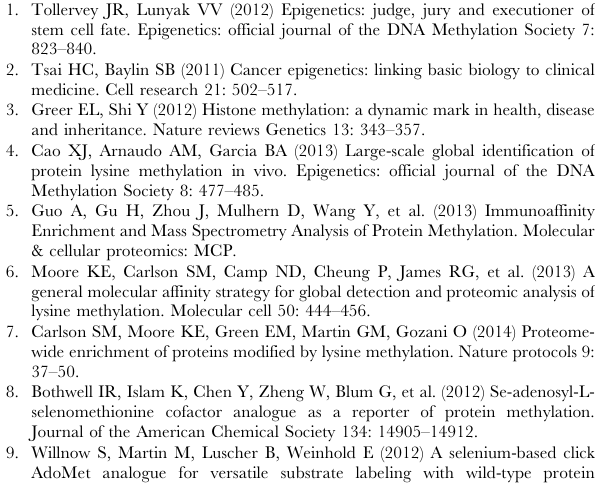
Table S1 Proteins labeled with ProSeAM by endogenous